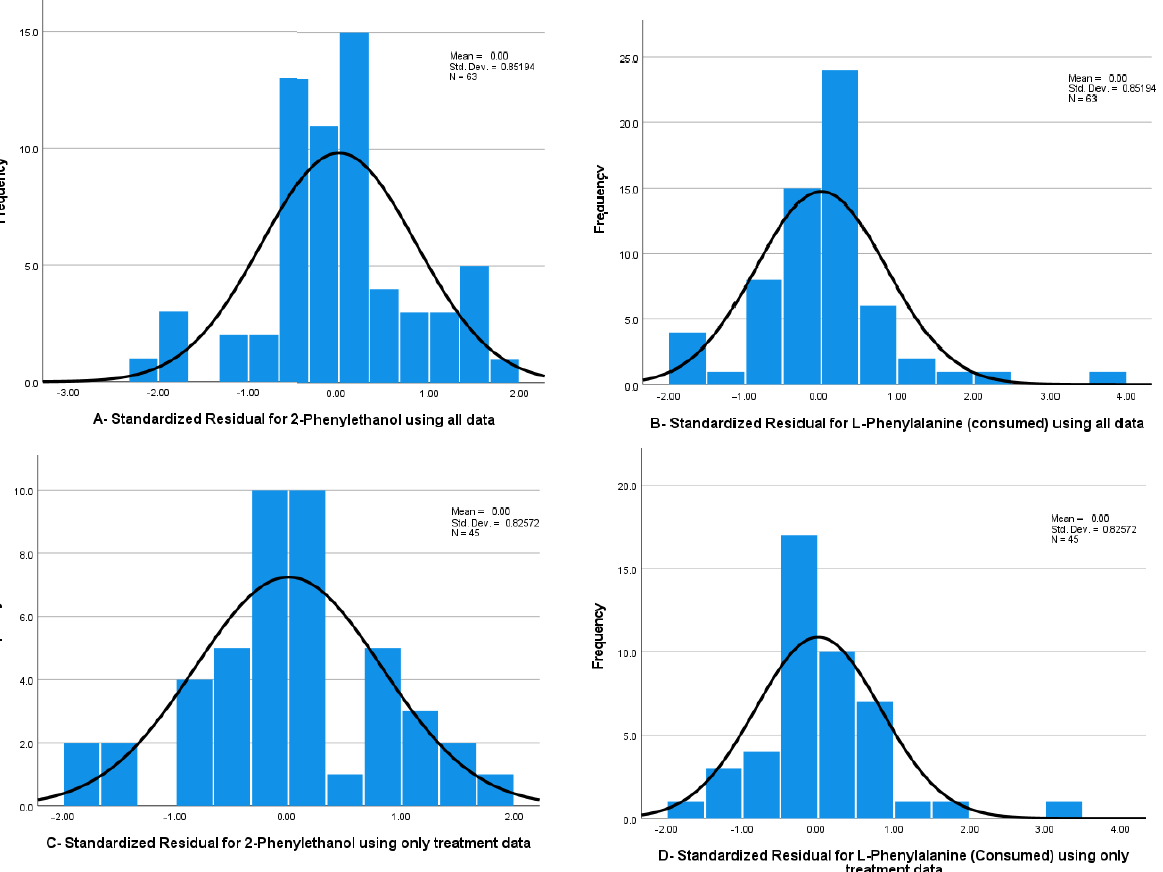
Figure 4. Series of frequency histograms displaying the standardised residuals (blue cloumn) with an ideal normal distribution overlayed (black line). ( A ); residuals standardised from estimations of 2-PE using the entire data set ( n = 63) note the deviations from normality at several points in the histogram. ( B ); residuals standardised from the estimations of L-phe consumed from the entire data set ( n = 63), note two deviations from normality. ( C ); residuals standardised from estimations of 2-PE from the treatment data set ( n = 45) note an improved normal distribution, with the only deviation from normality at the zero point, indicating a highly accurate estimate of 2-PE. ( D ); residuals standardised from the estimations of L-phe consumed for the treatment data note the distribution slightly improved, with a slight deviation from normality at the zero point.